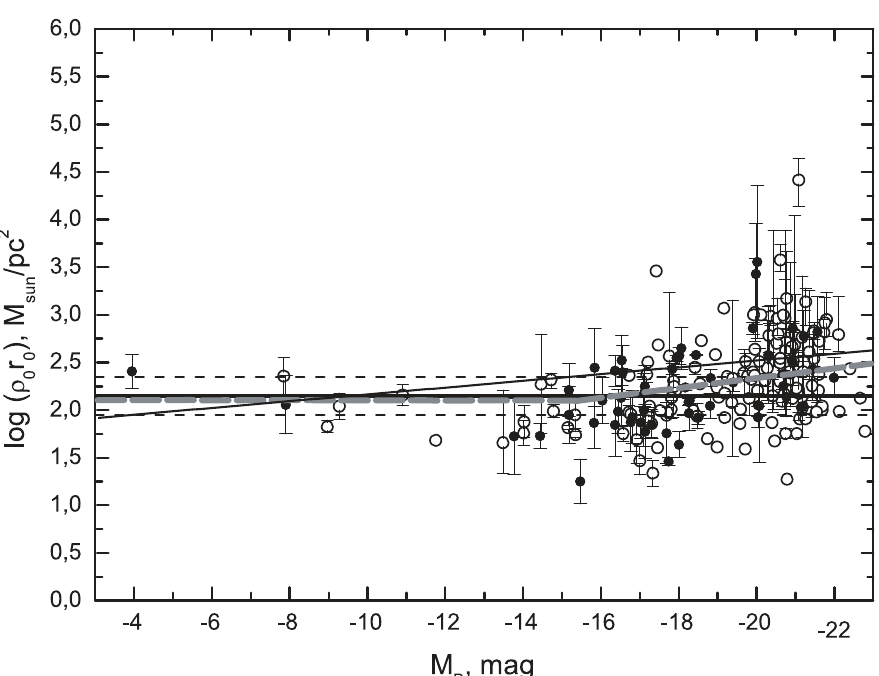
Fig. 3. The quantity ρ 0 r 0 in units of M (cid:12) / pc 2 as a function of galaxy magnitude for different galaxies and Hubble types. See explanation in the text.